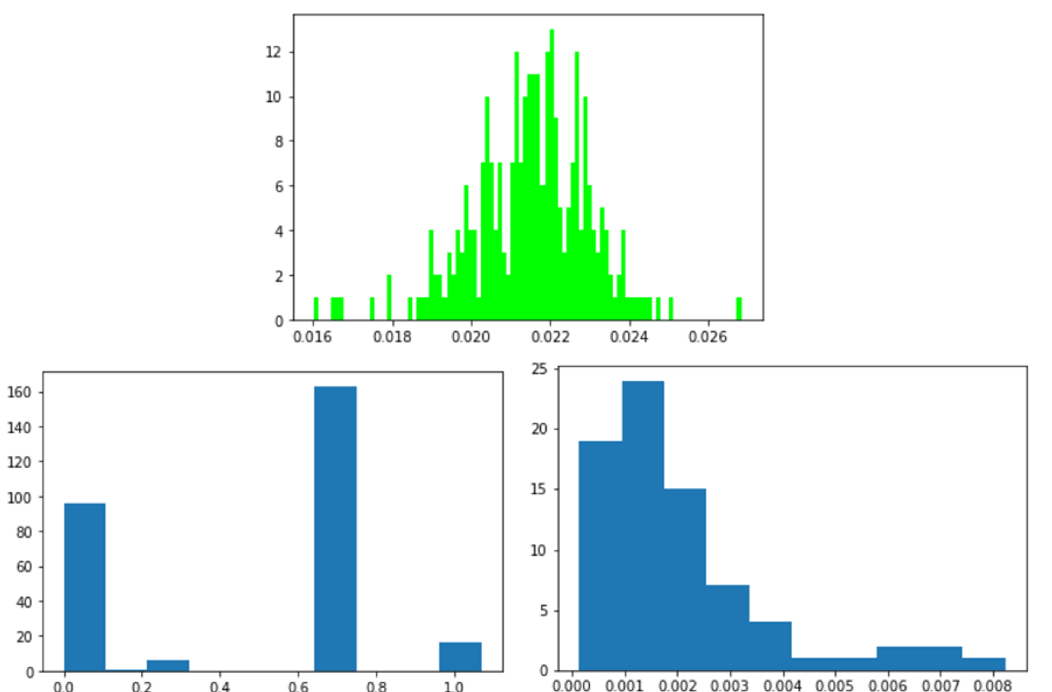
Figure 6 . Top : histogram plot with 100 bins generated by the maximum entropy of the principal axes of 282 random g s with respect to the C 2 ⊗ C 4 decomposition in su (8) . Bottom left : histogram plot with 10 bins of the maximum entropy of principal axes of g in the 282 solutions of su (8) w.r.t. the same decomposition. We note the strong tick on the left, but also the one on the right which are entries ∼ 0.69. It should be noted that the kaq search in those cases has settled on a basis that has lowered the sum of all entropies, and has managed to make the majority of principal axes disentangled but has left a few of the principal axes with high entropy. We hypothesize that the reason why some of the bins are empty is due to some common structure that the local minima of F 24 share, so that even though they are different local minima, they often land on bases that provide, to some approximation, the same maximum entropy among the principal axes. Bottom right : we zoom in on the leftmost bin of the previous plot with entries below 0 . 012 , and note not only a distribution skewed to the left, but also the fact that all 76 entries in this histogram are not captured in the random baseline on